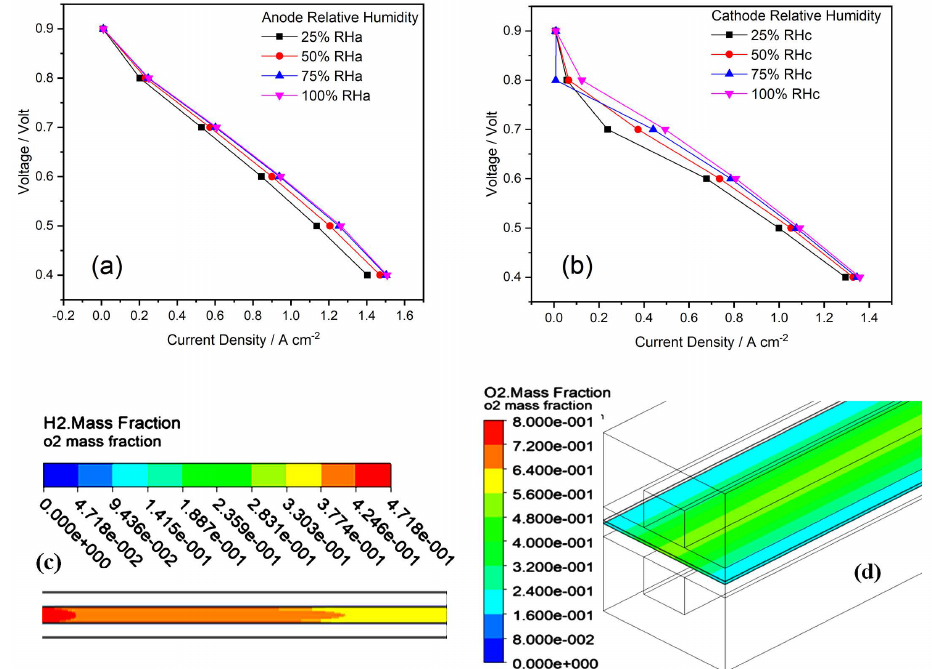
Figure 5. ( a – d ) Effect of relative humidity on performance of PEMFC: ( a , b ) Polarization curves of relative humidity at anode ( a ) and cathode ( b ), respectively. ( c , d ) Contours of mass fraction of H 2 ( c ) and O 2 ( d ), respectively.